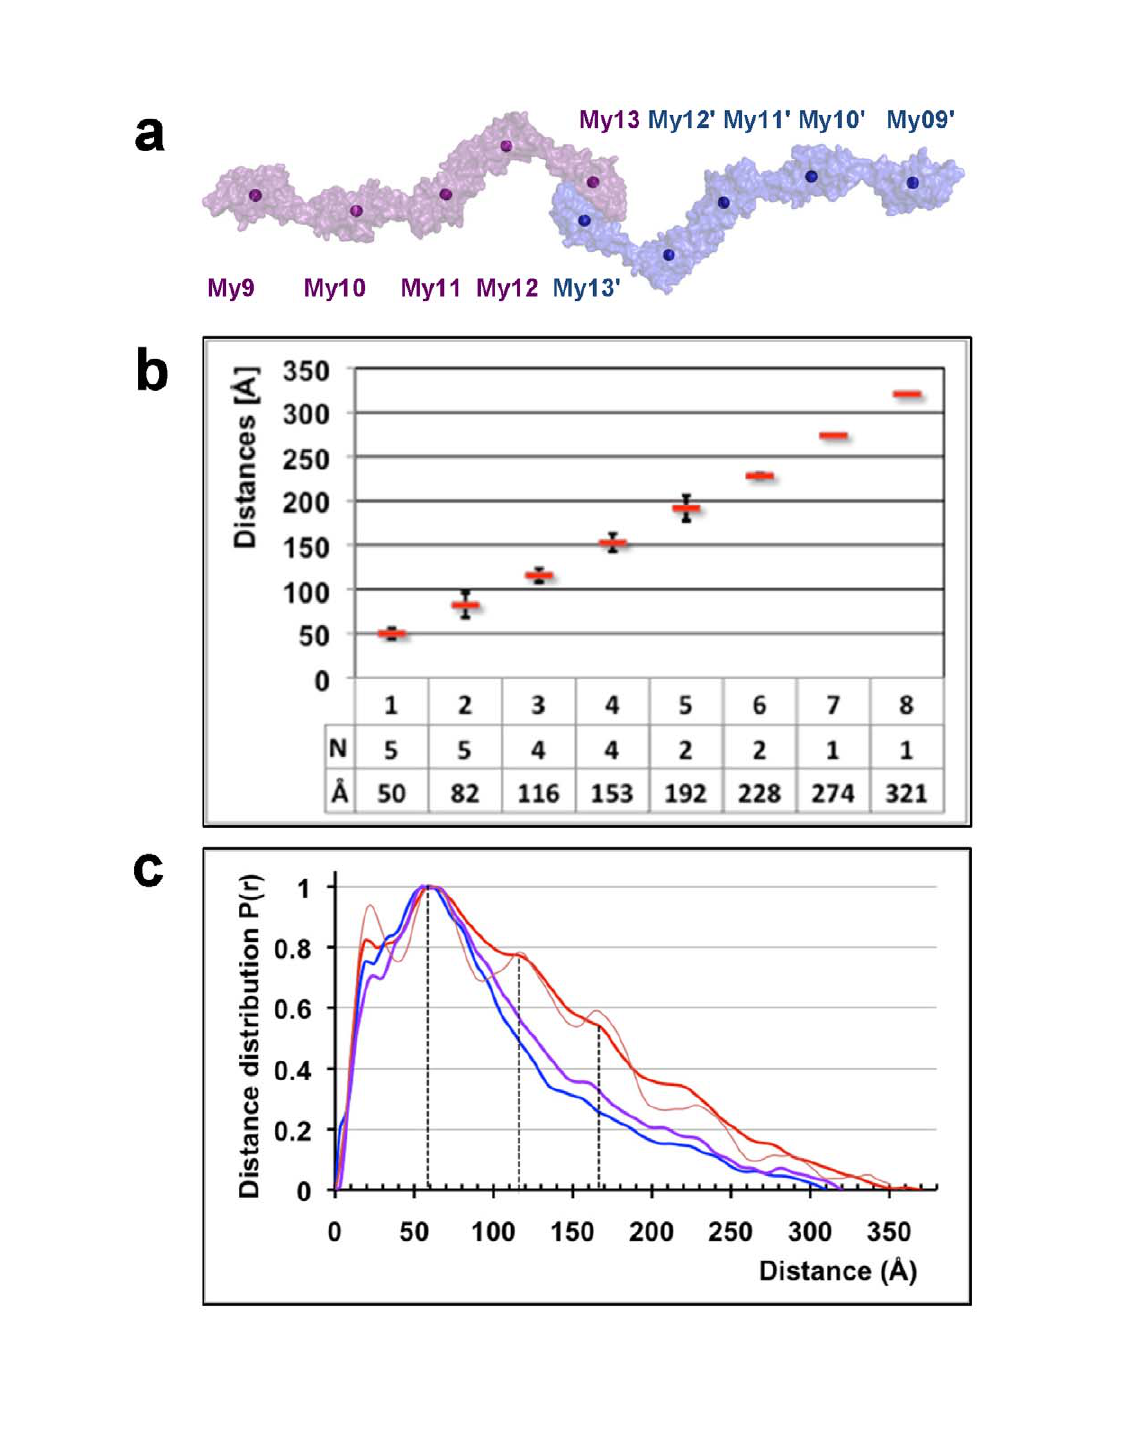
Figure 4. Analysis of the repetitive structural features of the My9–My13 tail-to-tail filament. (A) Surface presentation of the complete My9–My13 filament, with the centers of gravity indicated by spheres for each My domain. (B) Center of gravity distances, calculated for all My domain neighbor categories, from first ( n , n + 1) to eighth ( n , n + 8). (C) SAXS distance distribution plot of the wild-type My9–My13 filament (red) and two mutants K1457P (violet) and Y1551P (blue). The SAXS distance distribution plot calculated for the composite My9–My13 X-ray model is shown for comparison (thin red line). Matching additional maxima at about 60 A˚, 115 A˚, and 165 A˚ distances are indicated by dashed vertical lines.